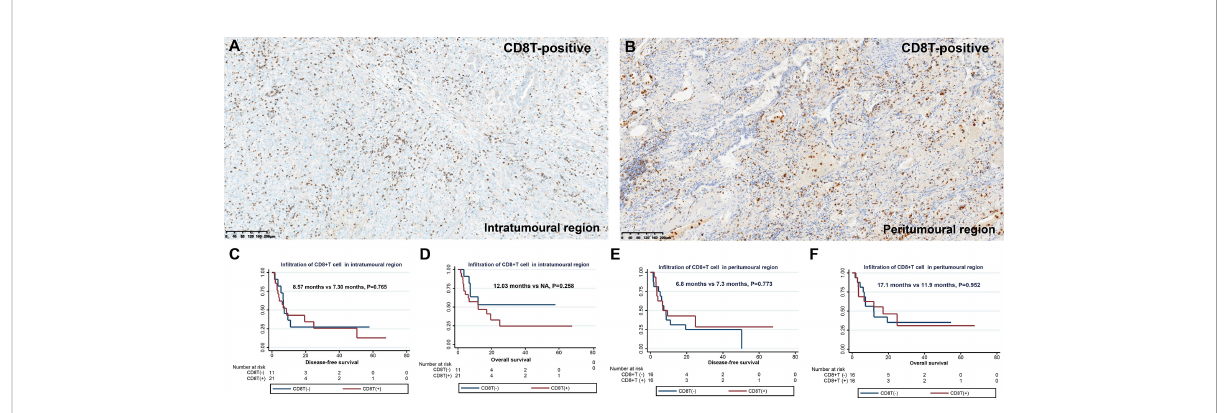
FIGURE 3 In fi ltration and clinical outcome of CD8+ T cells in PSC. In fi ltration of CD8+ T cells in the intratumoral region (A) and in the peritumoral region (B) ; DFS (C) and OS (D) of different CD8+ T cell in fi ltration states in intratumoral region; DFS (E) and OS (F) of different CD8+ T cell in fi ltration states in peritumoral region.